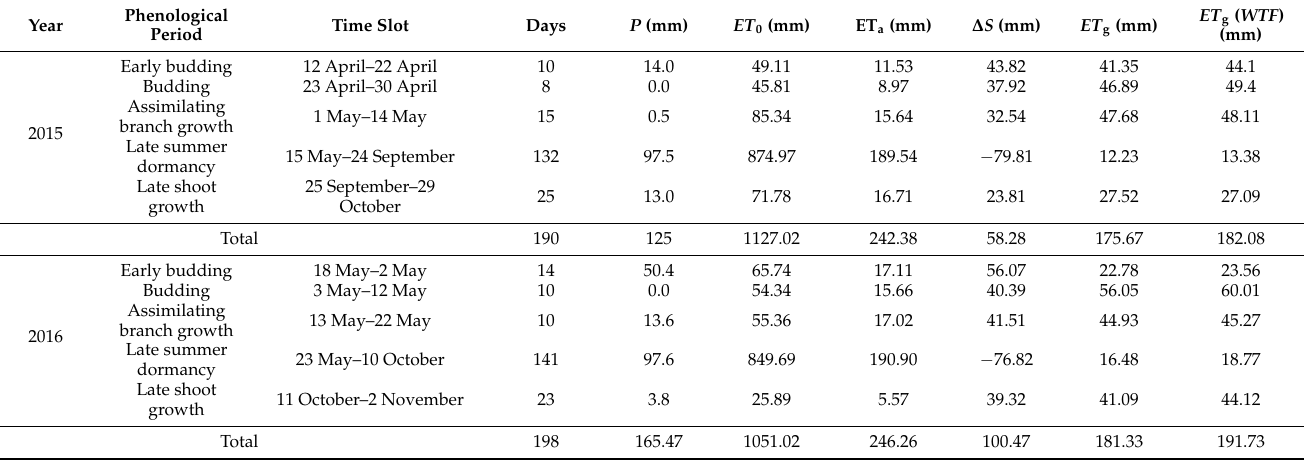
Table 7. Water balance in the H. ammodendron growth